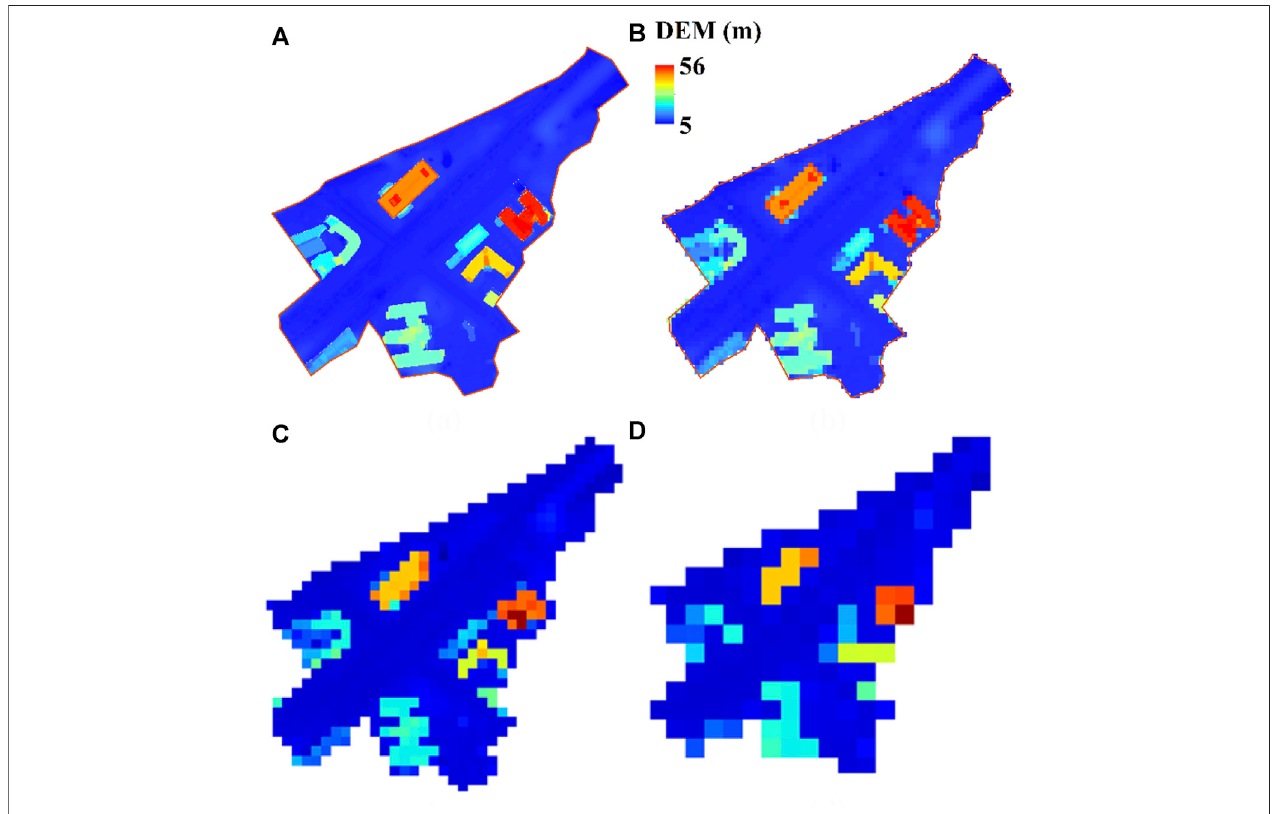
FIGURE 7 | Resampled DEM with spatial resolution of (a) 0.5 m; (b) 5 m; (c) 10 m; (d) 20 m.